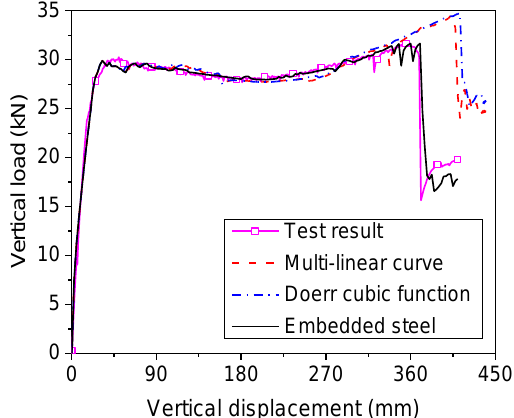
Figure 4. Effect of different bond models on load – displacement curve of